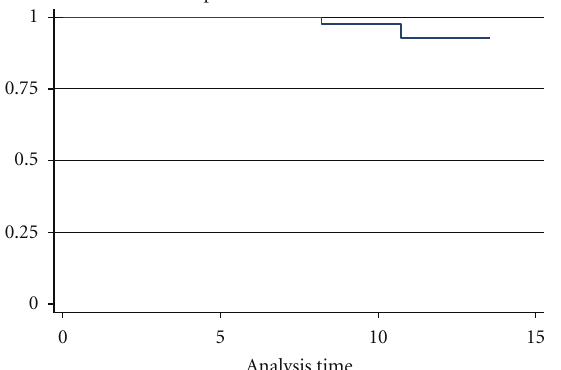
Figure 1: Local-Regional relapse-free survival curve for total cohort ( N =